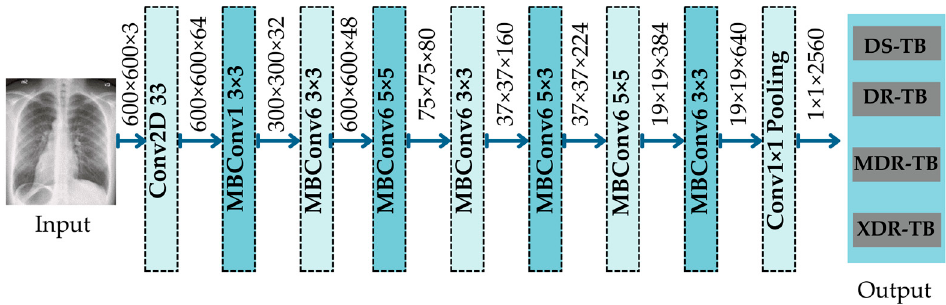
Figure 7. Architecture of EfficientNetB1.